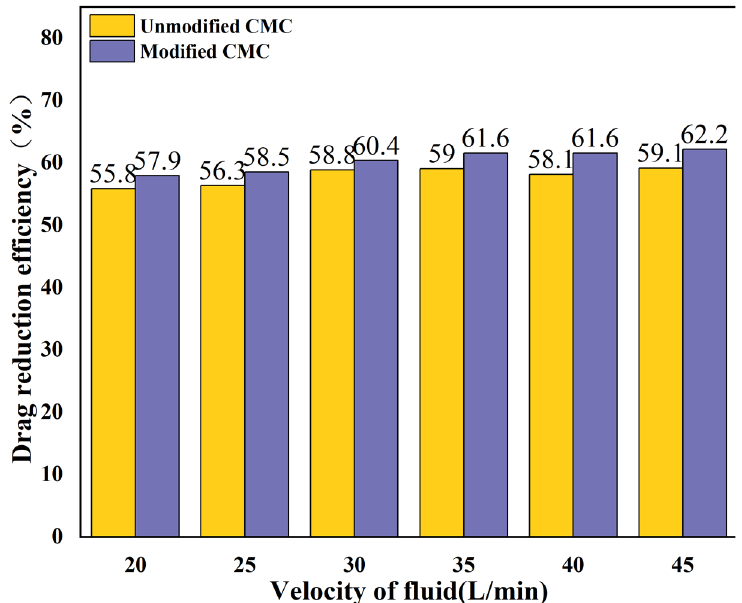
Figure 17. Comparison of drag-reduction rates of modified CMC and unmodified CMC at 0.05% concentration and 6 velocity of fluid.